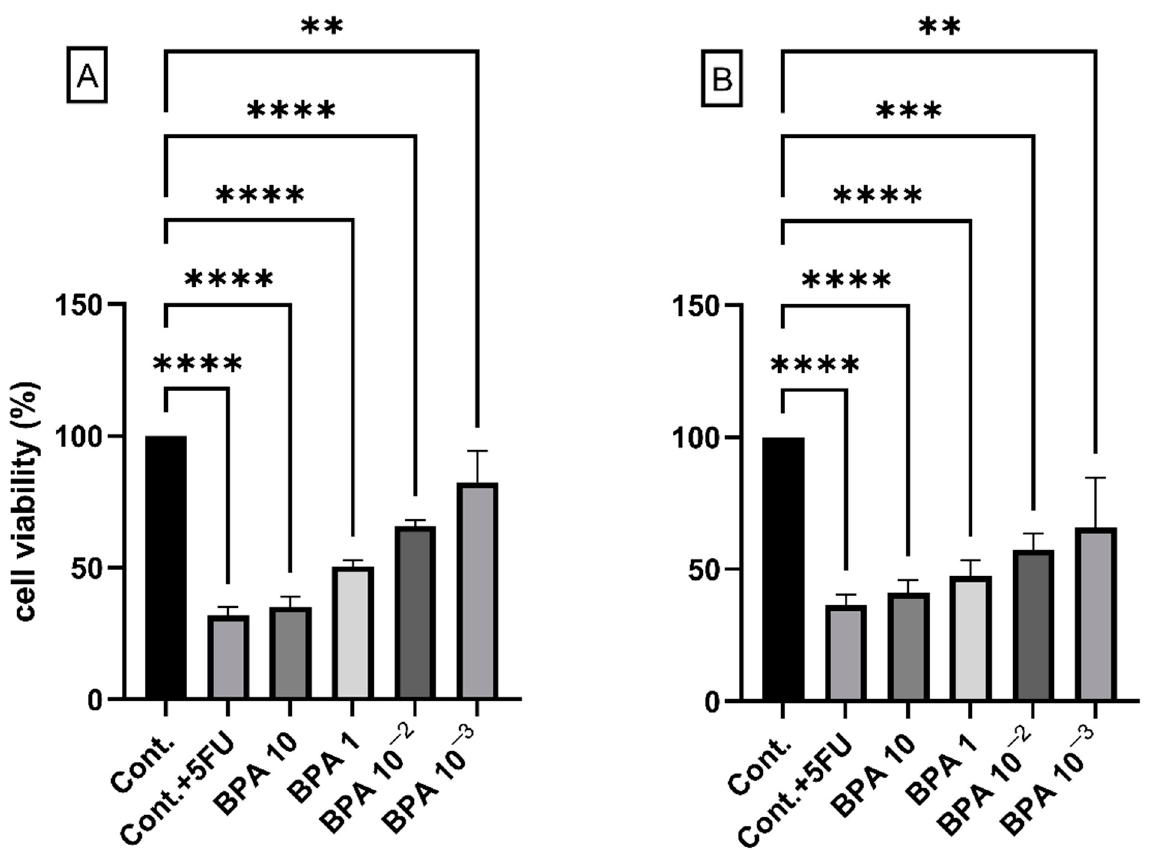
Figure 1. Representative graph showing the altered viability of ( A ) HCT116 and ( B ) HCoEpiC cells treated with decreasing concentrations of BPA (10, 1, 1.01, and 0.001 ug/mL) for 48 h. The control (cont.) was treated with the vehicle (DMSO) alone. The effect of overnight exposure to a therapeutic concentration of 5FU alone was used (second lane) as a reference. Data are shown as means ± SEMs, and ** p < 0.01, *** p < 0.001, and **** p < 0.0001. One-way ANOVA was followed by the Dunnett post-hoc test, with n = 3 (3 biological × 3 technical).